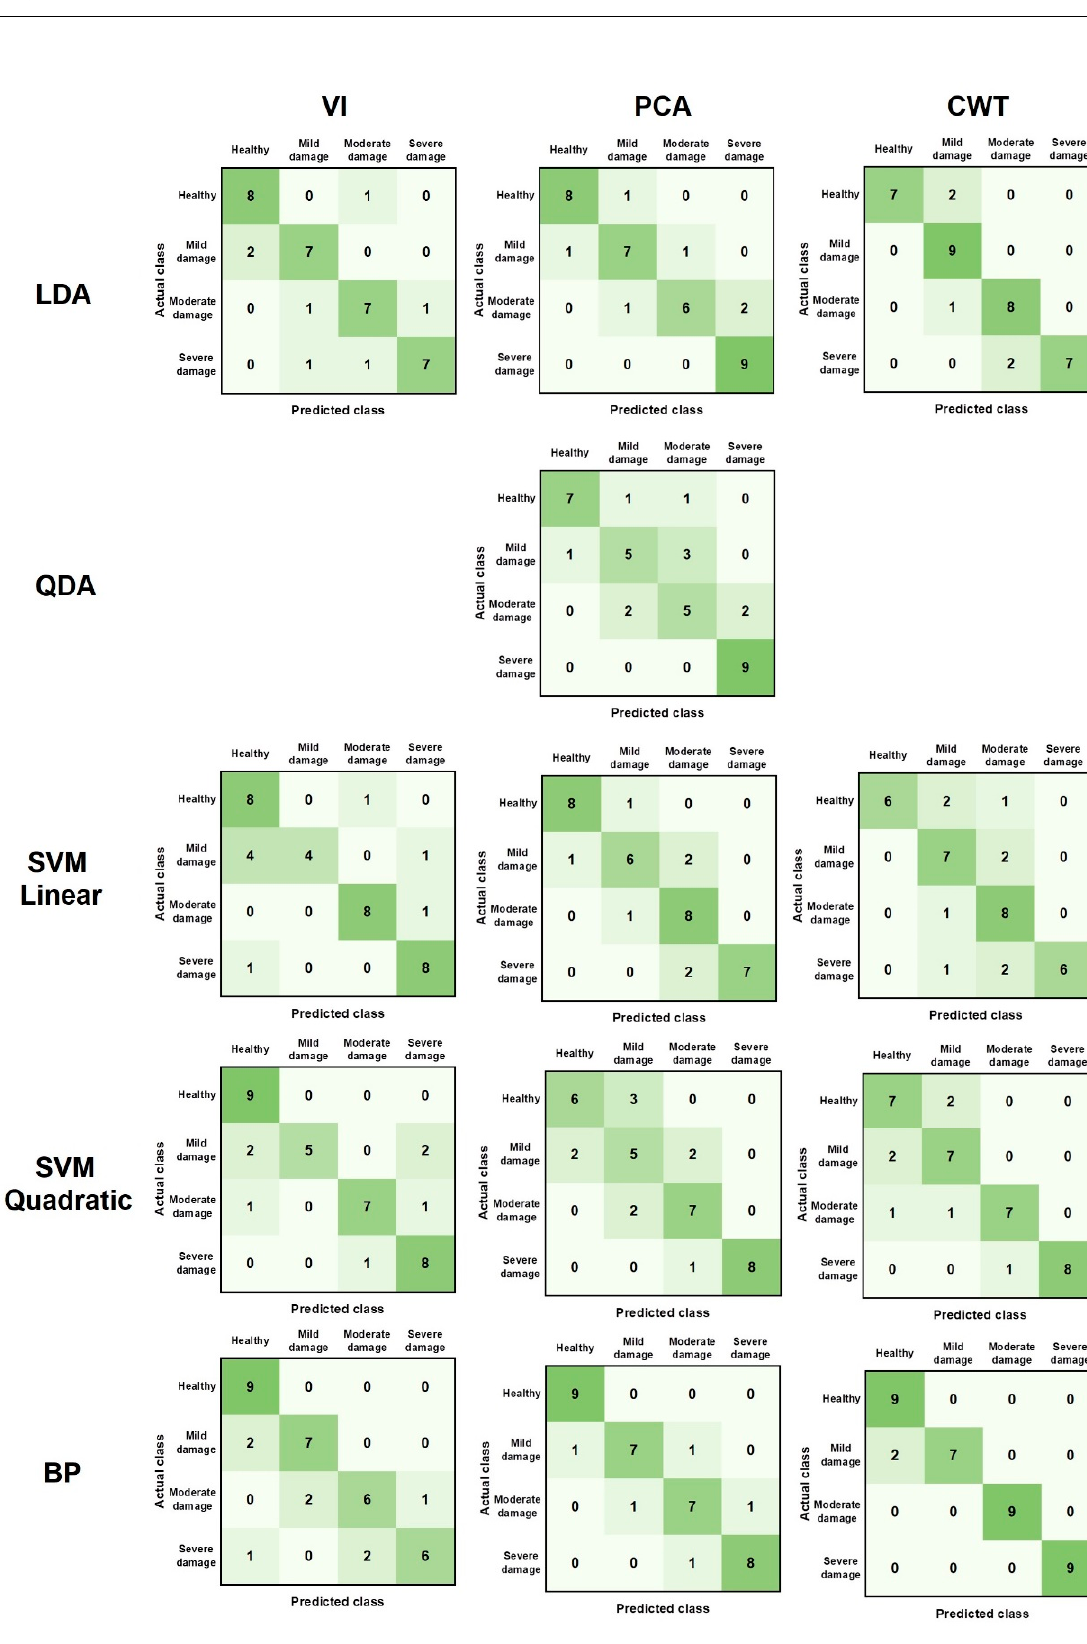
Figure 9. Verification accuracy of different classification methods ( n = 36).